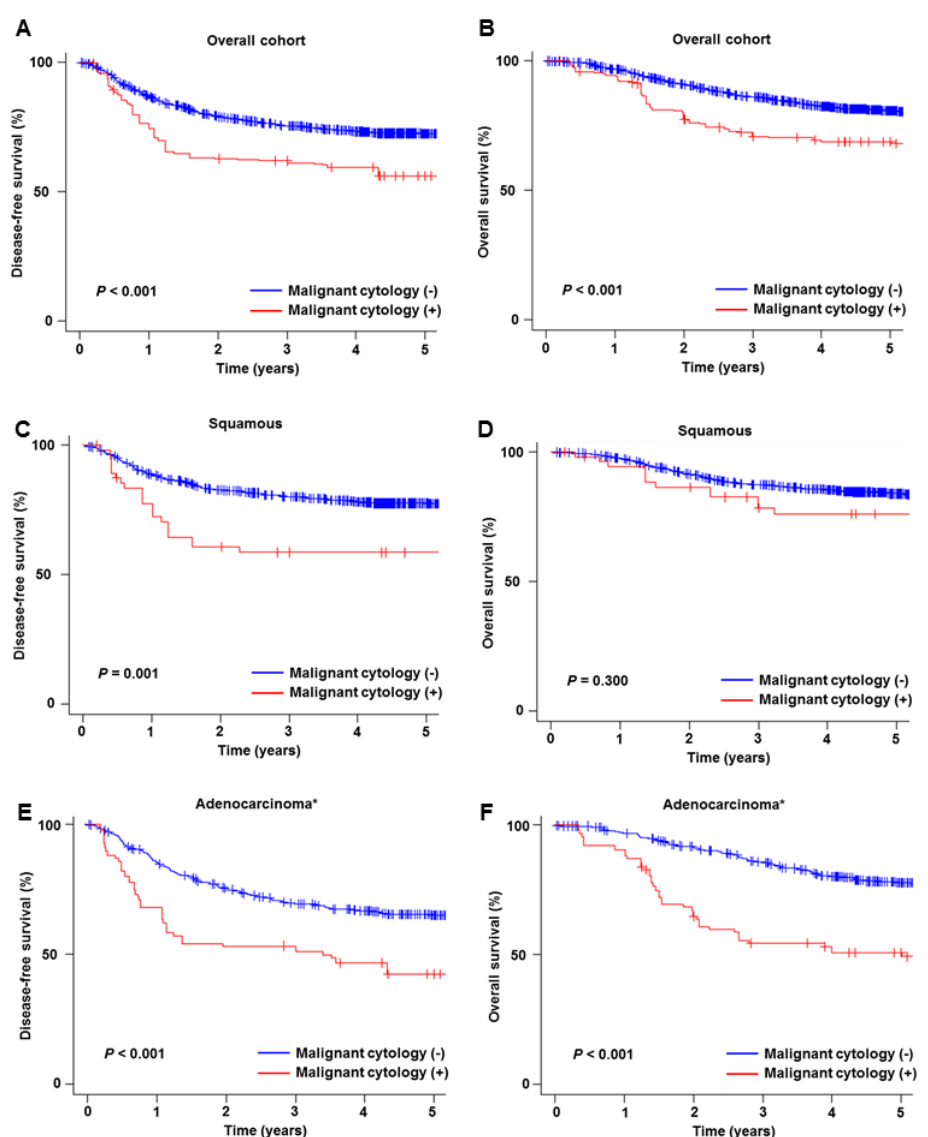
Figure 4. Survival outcome based on peritoneal cytology results. Kaplan-Meier curves are shown based on presence and absence of malignant cells in the peritoneal cytology tests for overall cohort (DFS for panel A , and OS for panel B ), squamous cell carcinoma (DFS for panel C , and OS for panel D ), and adenocarcinoma / adenosquamous carcinoma (DFS for panel E , and OS for panel F ). Log-rank test for P -Values on propensity score inverse provability of treatment weighting. * including adenosquamous carcinoma. Abbreviations: DFS, disease-free survival; and OS, overall survival.